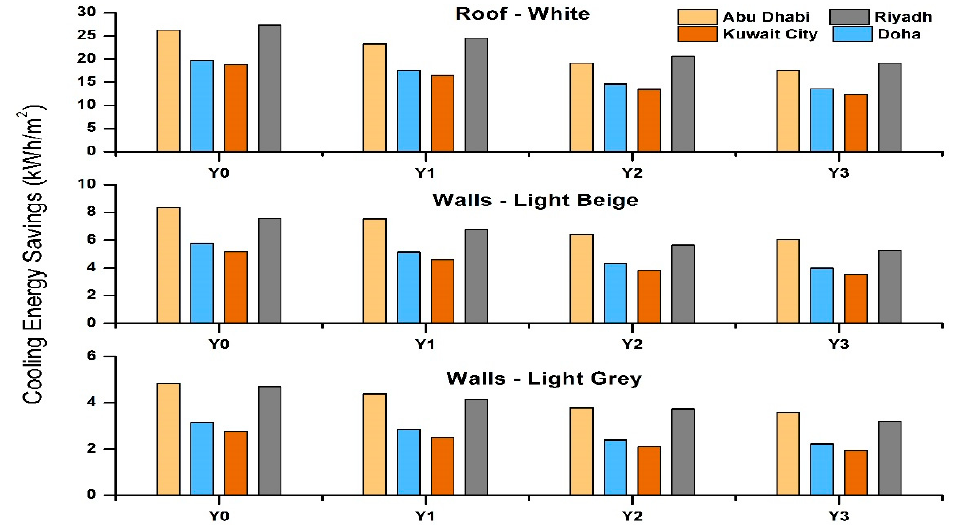
Figure 21. Cooling load reduction with the aging of high SRI paints aging for various GCC locations. On the other hand, for cool wall retrofitting, the highest savings were observed for Abu Dhabi (8.4 kWh/m 2 for light beige) and the least for Kuwait (1.9 kWh/m 2 for light grey) among the colors considered. It is noteworthy to observe here that Abu Dhabi had